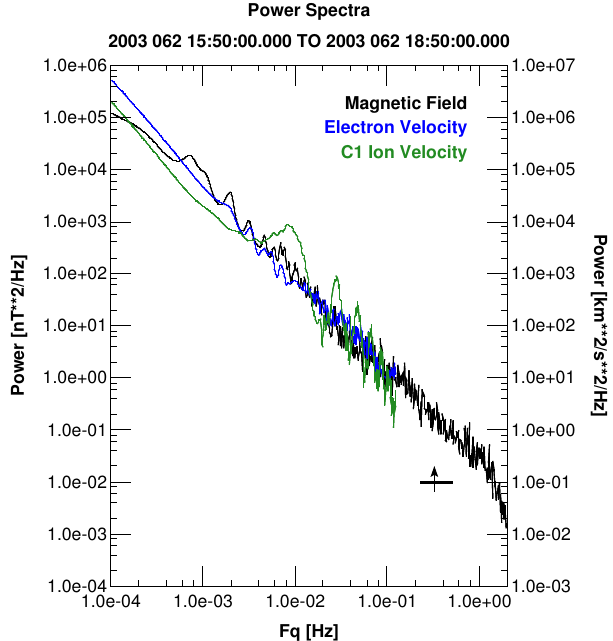
Fig. 10. Example spectra of the Magnetic Field (black - lefthand axis) and the electron and ion fluid velocity (blue and green respectively - righthand axis) for the same time period as shown in the lower plot in Figure 8. The time resolution of the magnetic field and velocity data was 0.2s and 4s respectively. The electron velocity data has had high frequency noise above 0.06 Hz removed. This tends to flatten the spectra. The spectral indices of the magnetic and velocity spectra are about -1.7. The arrow shows the position of the λ T scale estimated from this study.